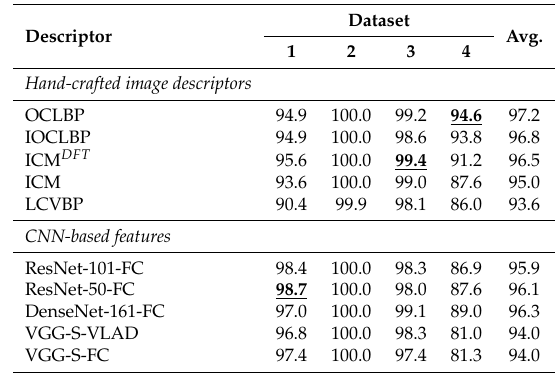
Table 11. Results of Experiment #5: stationary textures with rotation. Figures report overall accuracy by dataset. Boldface denotes the highest value; underline signals a statistically-significant difference between the best hand-crafted and the best CNN-based descriptor. Descriptors are listed in ascending order of by-experiment rank (best first).